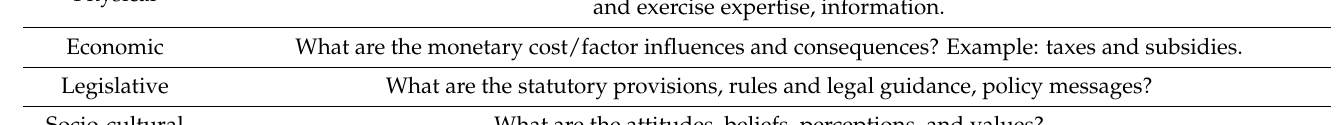
Table 1. Analysis grid for environments linked to obesity (ANGELO). Macro-Environment, Diet-Related and Physical Activity-Related (National, Regional, Sectors, Food Industries, Media,